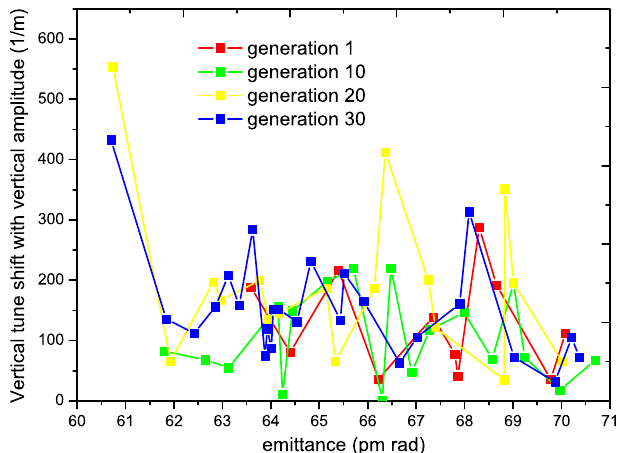
FIG. 9. The vertical tune shift with vertical amplitude. The different color means the optimal solutions obtained at different